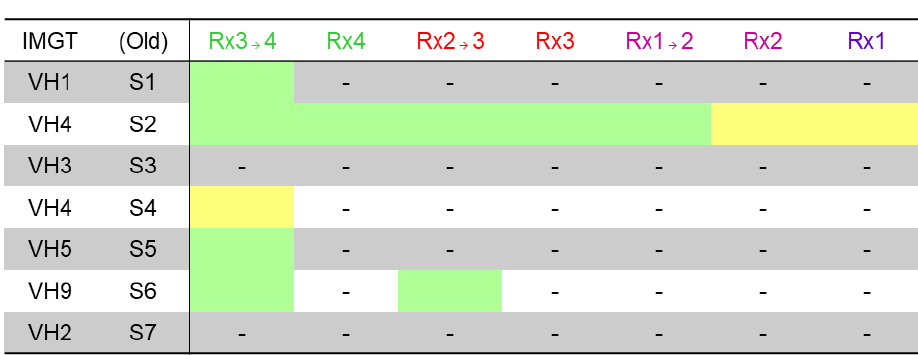
Figure 1. Optimisation of IgHV gene recoveryM. ( A ) ELISA data for horse plasma screened against D. polylepis whole venom (left) or ECoV-NC99 CTD+SD1 (right), Absorbance (OD450 nm) is shown on the y -axis, and plasma dilution on the x -axis. The two horses selected for this study are shown in green and red. ( B ) Location of gene specific primers relative to the heavy chain open reading frame (IgH ORF) is shown. Several IgH V -specific primers were designed in the leader sequence (EQ-HV screening) and paired with complimentary reverse primers for amplifying almost the entire heavy chain ORF (Rx1: Eq-IgCH3-R, purple) or smaller fragments by regular or nested PCR